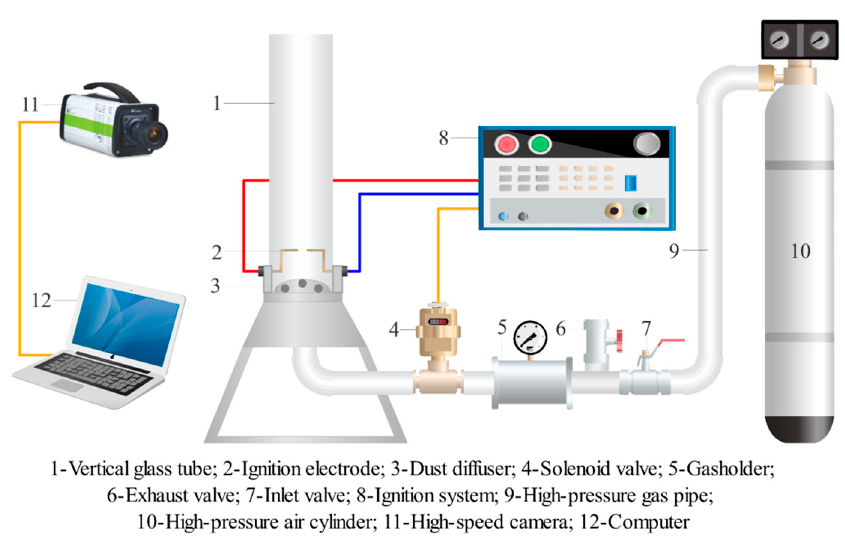
Figure 2. The vertical glass tube test apparatus.